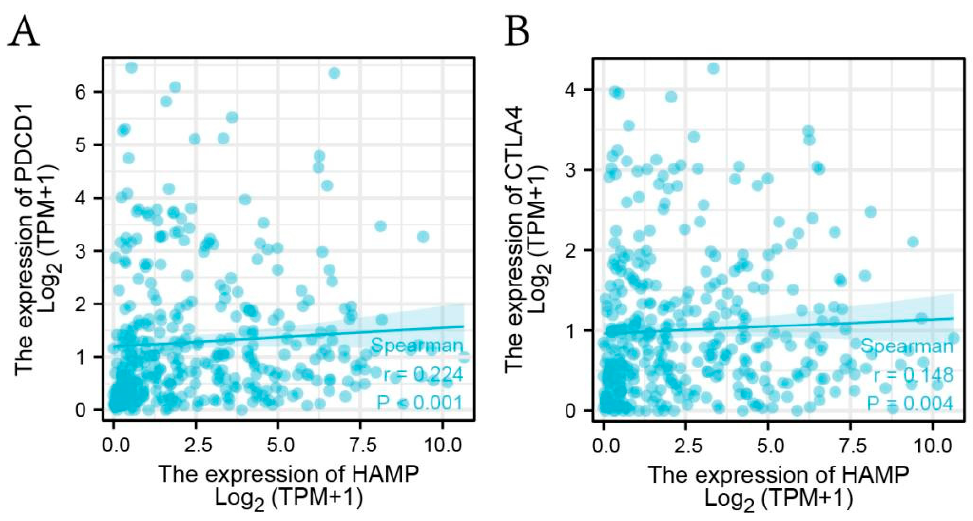
Figure 8. Correlation of HAMP expression with the infiltration of 24 immune cells.